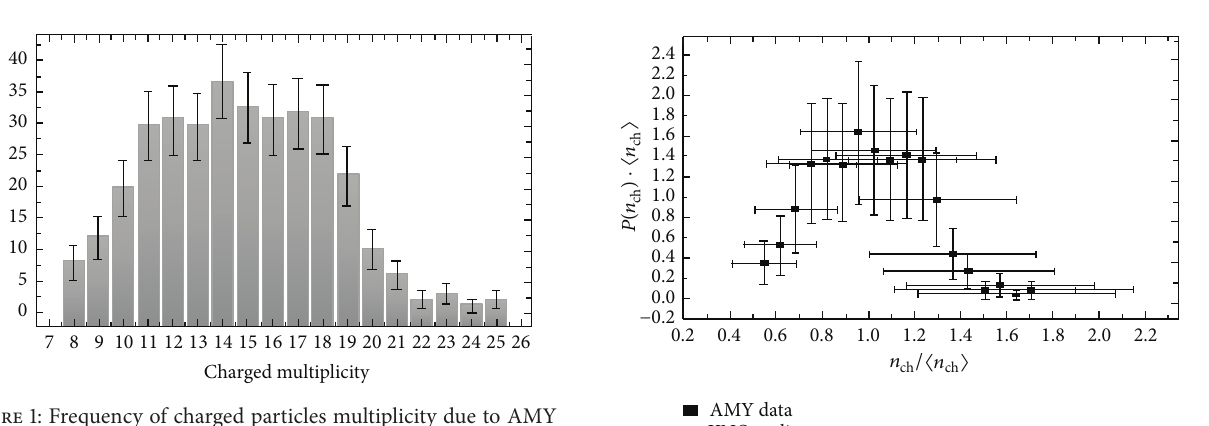
Figure 1: Frequency of charged particles multiplicity due to AMY data.